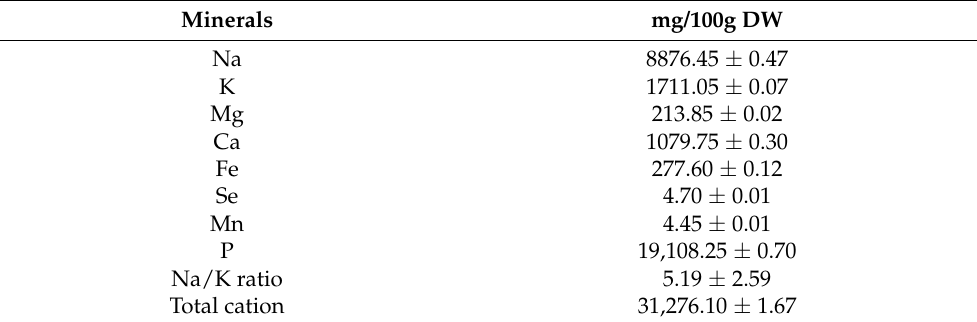
Table 3. Mineral content of brown seaweed, S. polycystum